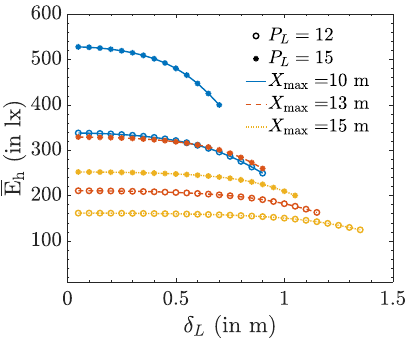
Figure 2. Horizontal illuminance average E h for X max = Y max = { 10,13,15 } m, P L = { 12,15 } and Φ typ = 270 v